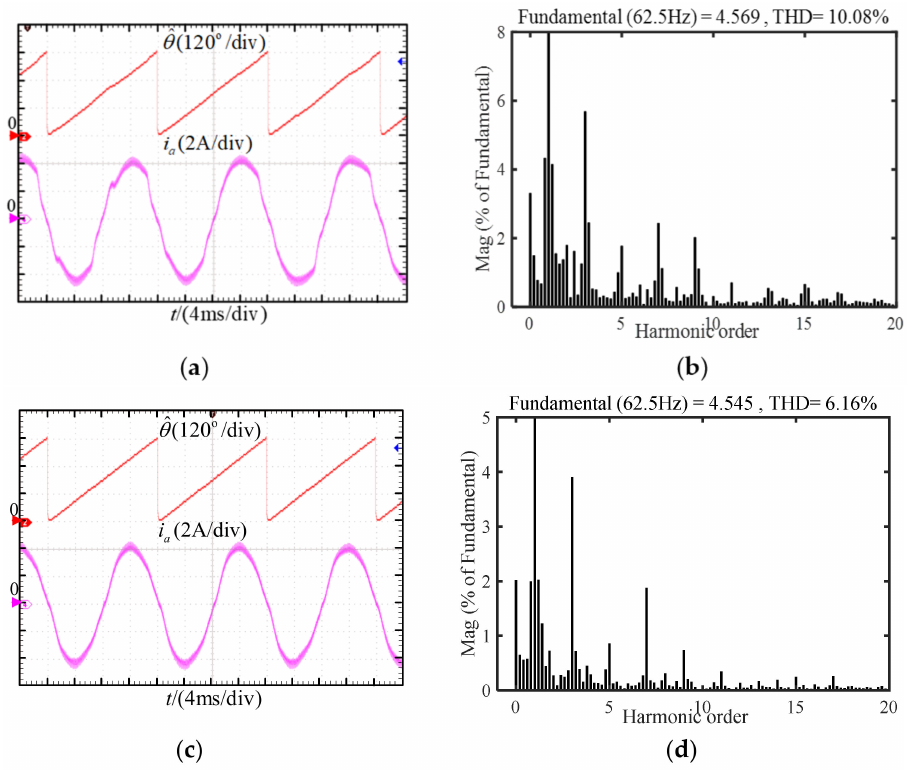
Figure 15. ( a ) Position and current with Luenberger observer; ( b ) FFT analysis of phase current with Luenberger observer; ( c ) Position and current with the dual observer; ( d ) FFT analysis of phase current with the dual observer.